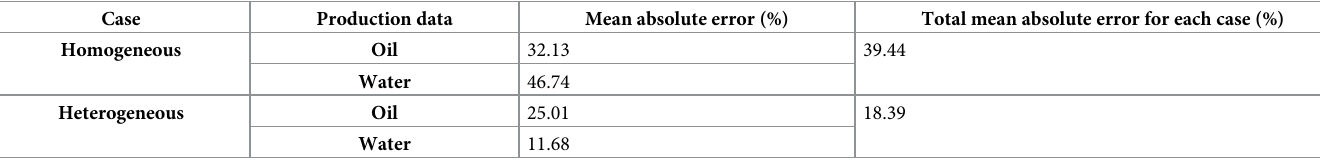
Table 9. Mean absolute error between the numerical results and the field data.